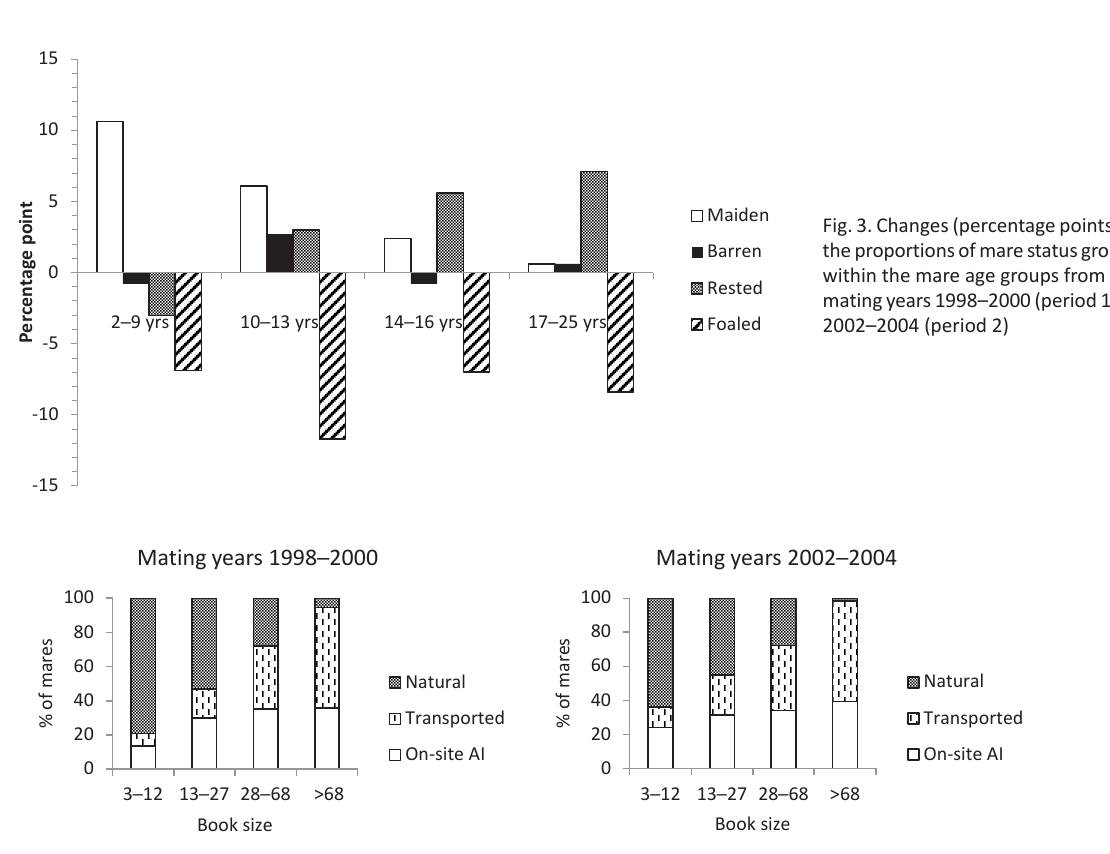
Fig. 4. Distribution of mating types within book size groups for mating years 1998–2000 (period 1) and 2002–2004 (period 2) Table 2. Multivariable logistic mixed model results for mare age, mare status, mating type and book size to test differences in foaling rates (FR) of Finnhorse mares between two time periods. Results are adjusted for other independent variables, and for interaction of mating type and book size where appropriate. Mare and stallion were incorporated as random effects. An odds ratio (OR) between 0 and 1 indicates that the foaling rate in period 2 (2002─2004) was lower than in period 1